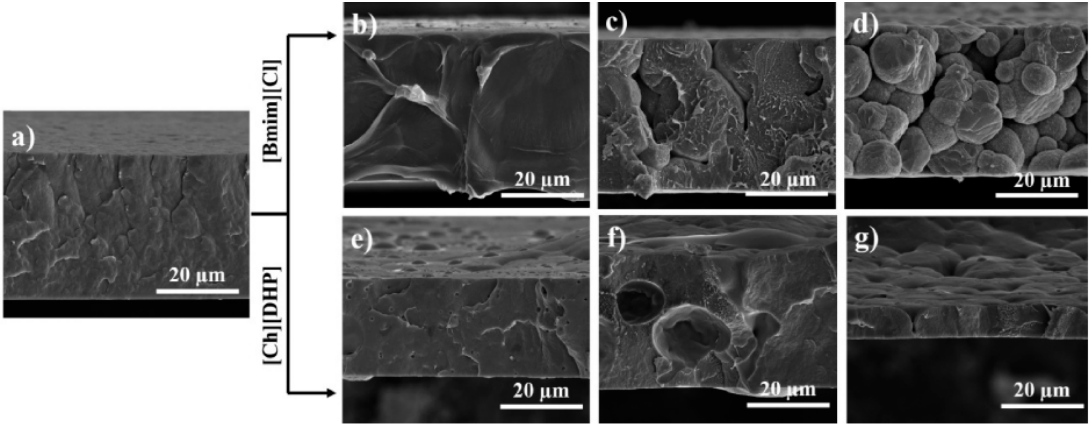
Figure 7. Cross section SEM images of ( a ) PVDF pristine and composite films with ( b ) 10% wt. [Bmim][Cl], ( c ) 20% wt. [Bmim][Cl], ( d ) 40 wt% [Bmim][Cl], ( e ) 10 wt% [Ch][DHP], ( f ) 20 wt% [Ch][DHP], and ( g ) 40 wt% [Ch][DHP]. Reprinted with permission from [114].